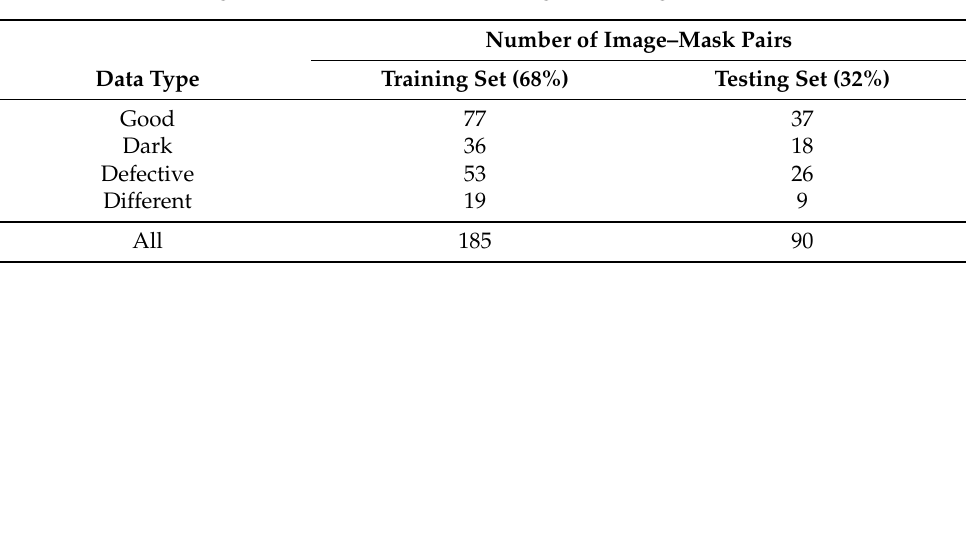
Table 1. Annotated images ratio of dataset for AI training and